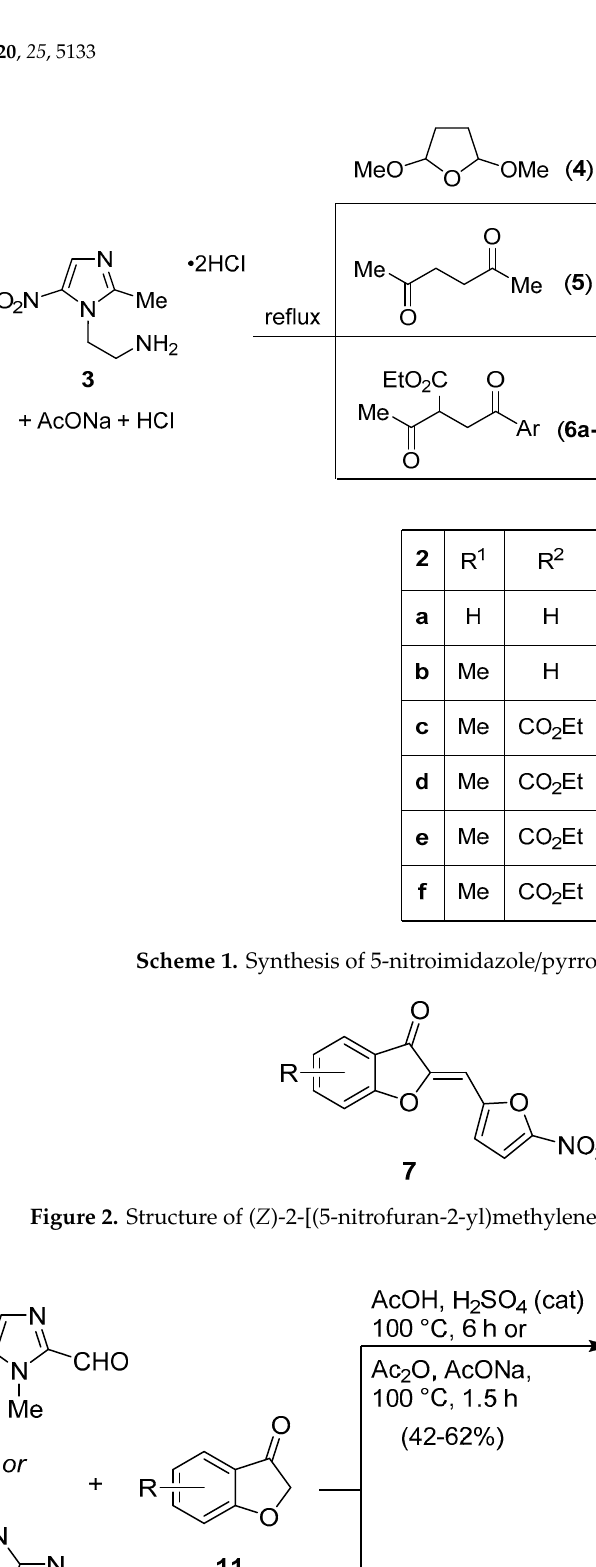
Figure 2. Structure of ( Z )-2-[(5-nitrofuran-2-yl)methylene]benzofuran-3(2 H )-ones 7 .